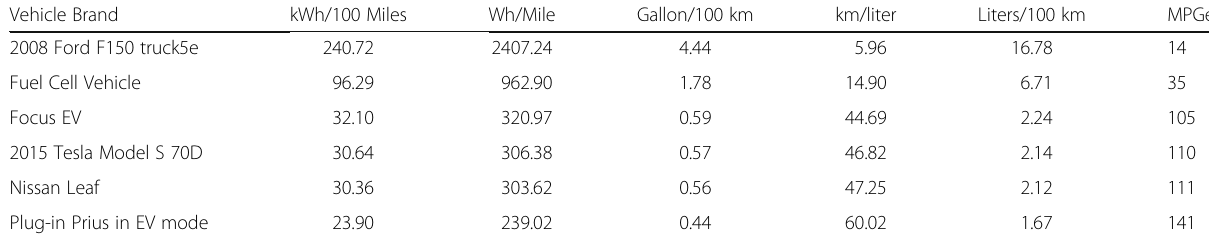
Table 1 Covert labeled MPGe of EVs to Wh/Mile Vehicle